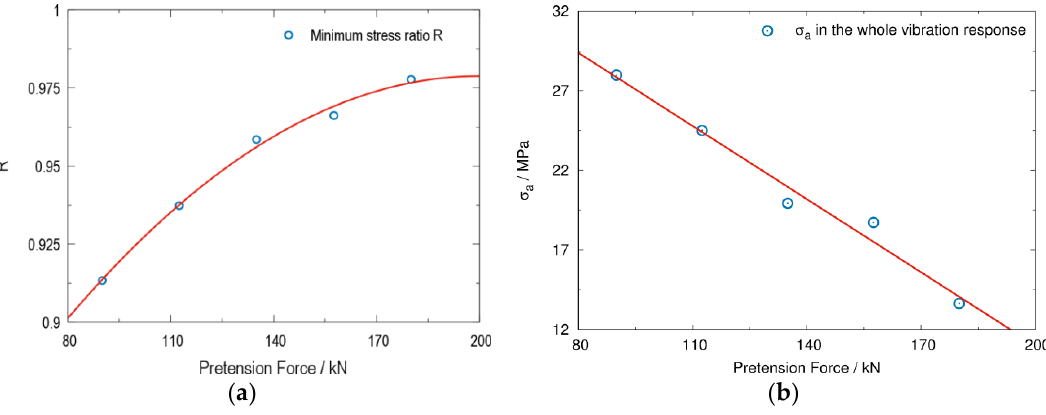
Figure 13. The variation of ( a ) the minimum stress ratio R ; and ( b ) the maximum stress and stress amplitude with the decreasing of the pretension force in the whole vibration response of the bolts.